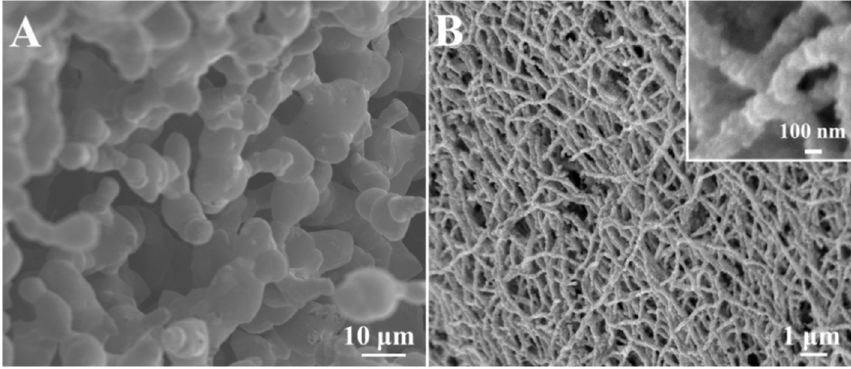
Figure 4. Typical SEM images of ( A ) porous Ag and ( B ) Ag-NiO nanofibers, respectively. The insets show the SEM image with a higher magnification.